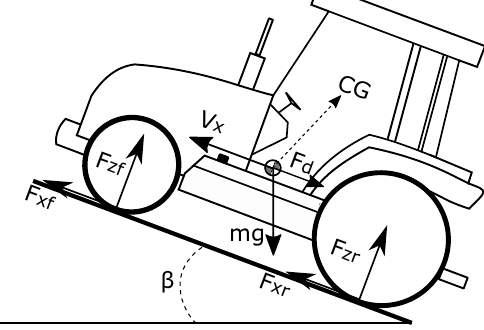
Figure 1. 1D longitudinal tractor